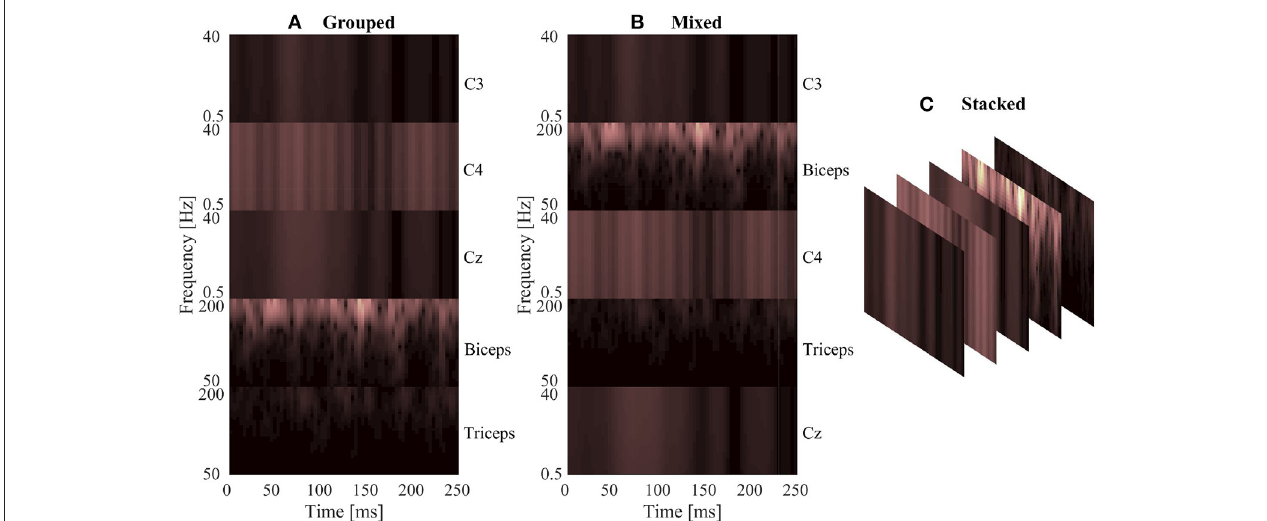
FIGURE 2 | A sample normalized spectrogram image to demonstrate the three EEG–EMG fusion methods used, where (A,B) show single-channel spectrograms and (C) visualizes a multi-channel spectrogram. (A) Shows the grouped method, where signal channels of the same type are grouped together within the image. (B) Shows the mixed method, where EEG and EMG channels are alternated to mix signal types. (C) Provides a visualization of the stacked method, where a multi-channel spectrogram is generated by combining the different EEG/EMG spectrograms in depth-wise manner.